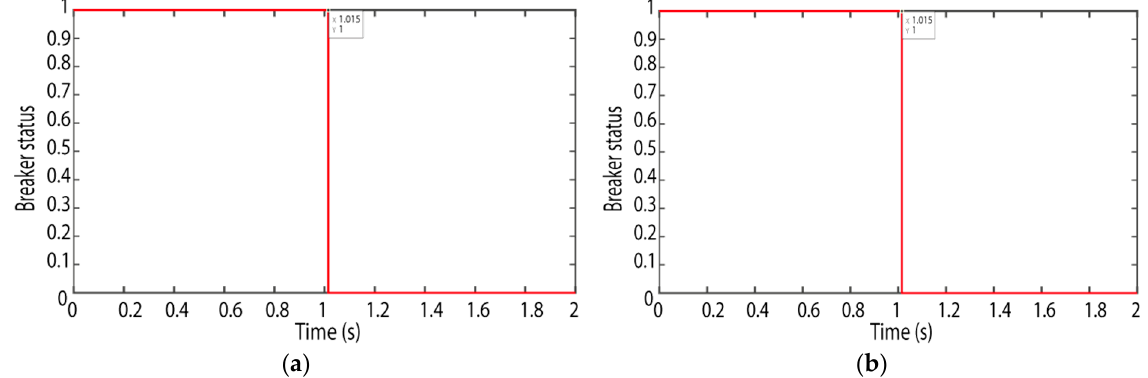
Figure 12. Breaker status for ( a ) CB3 and ( b ) CB4 during double-line-to-ground fault.